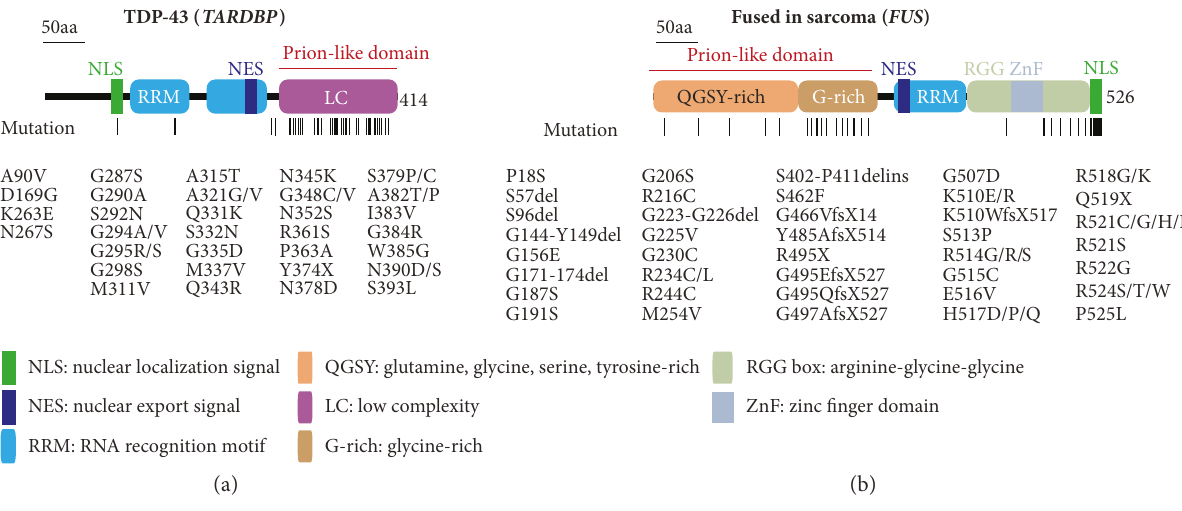
Figure 1: Domains and mutations for TDP-43 and FUS. Schematic and domain representation of ALS-FTD-linked mutations in TDP-43 and FUS. Lines indicate the locations of identi fi ed